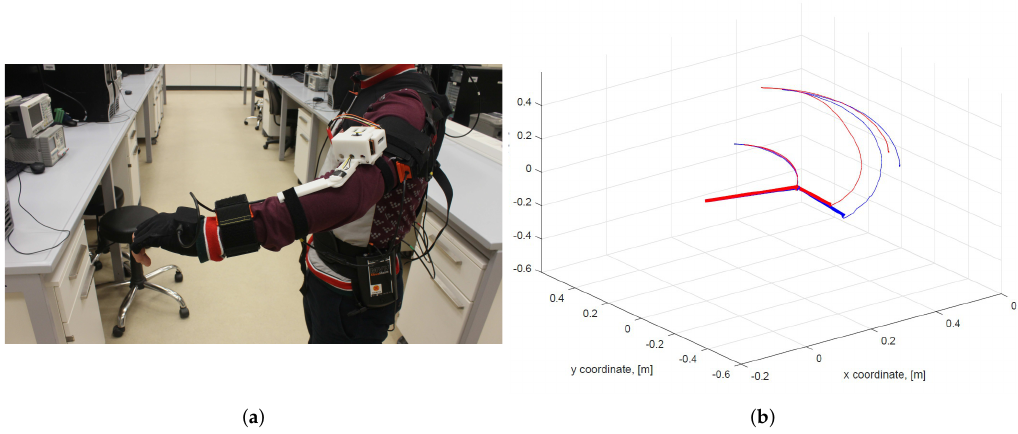
Figure 7. ( a ) The 4-DOF arm tracker (Phase-1) system prototype and Xsens MVN suit on a human user for comparative analysis and ( b ) the captured arm trajectories: blue—the Phase 1 system prototype, red—Xsens MVN suit. Thick lines represent arm segments [22].